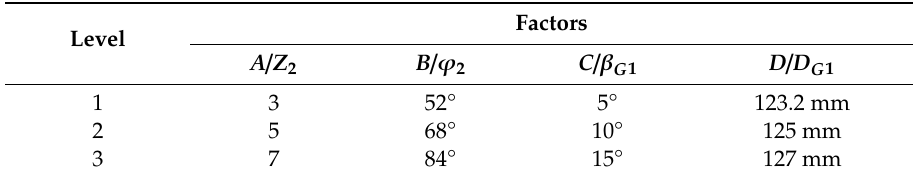
Table 10. Levels of the orthogonal experimental factors.